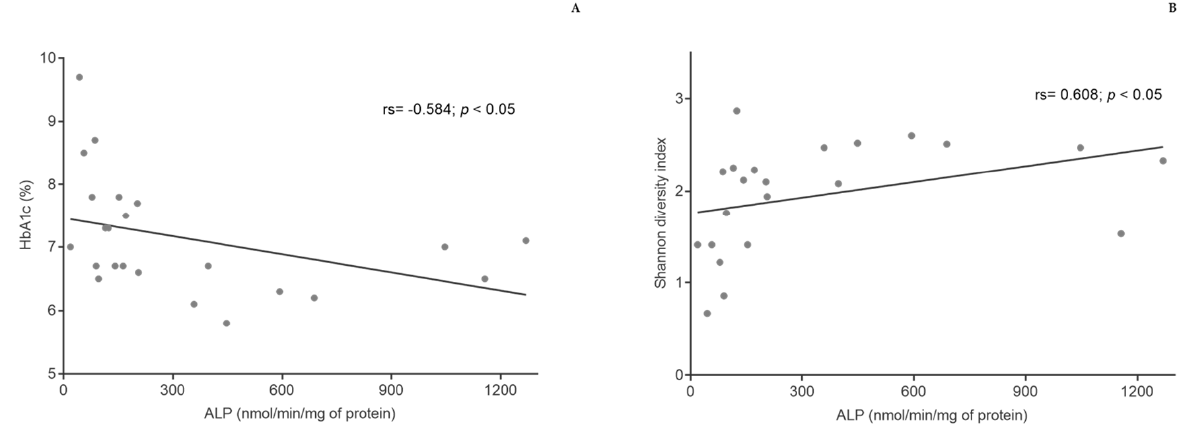
Figure 5. Correlations between HbA1c and ALP ( A ) and bacterial diversity and ALP ( B ). HbA1c—glycated hemoglobin; ALP—alkaline